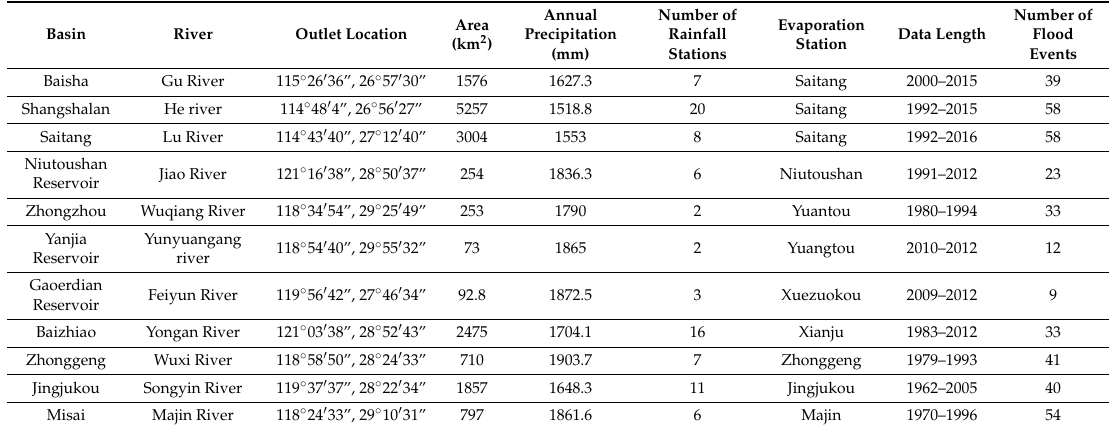
Table 6. General information of the studied